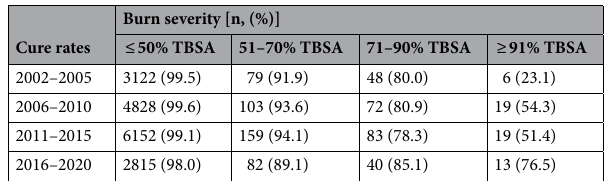
Table 2. The distribution of cure rates by burn severity.